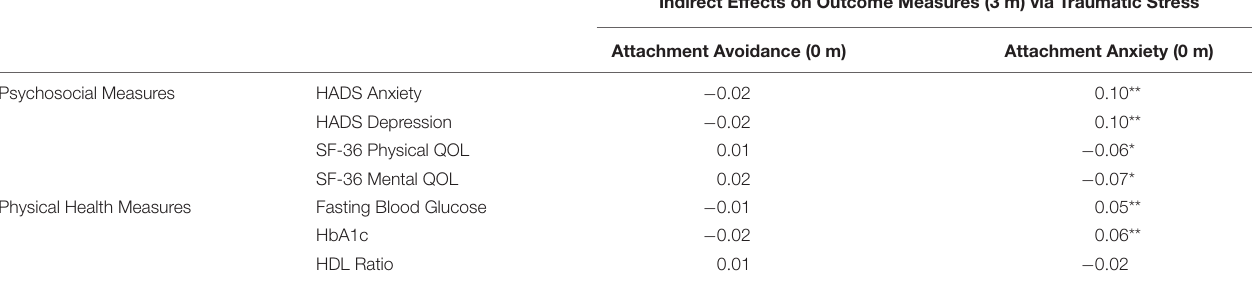
TABLE 4 | Standardized indirect effects for multivariate structural equation